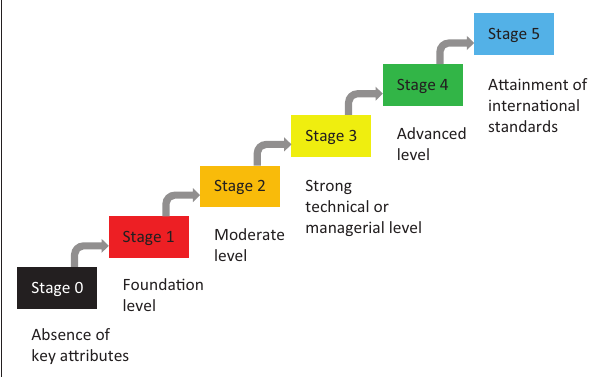
FIGURE 1: Maturation stages proposed for each core capability (or function) of the national laboratory